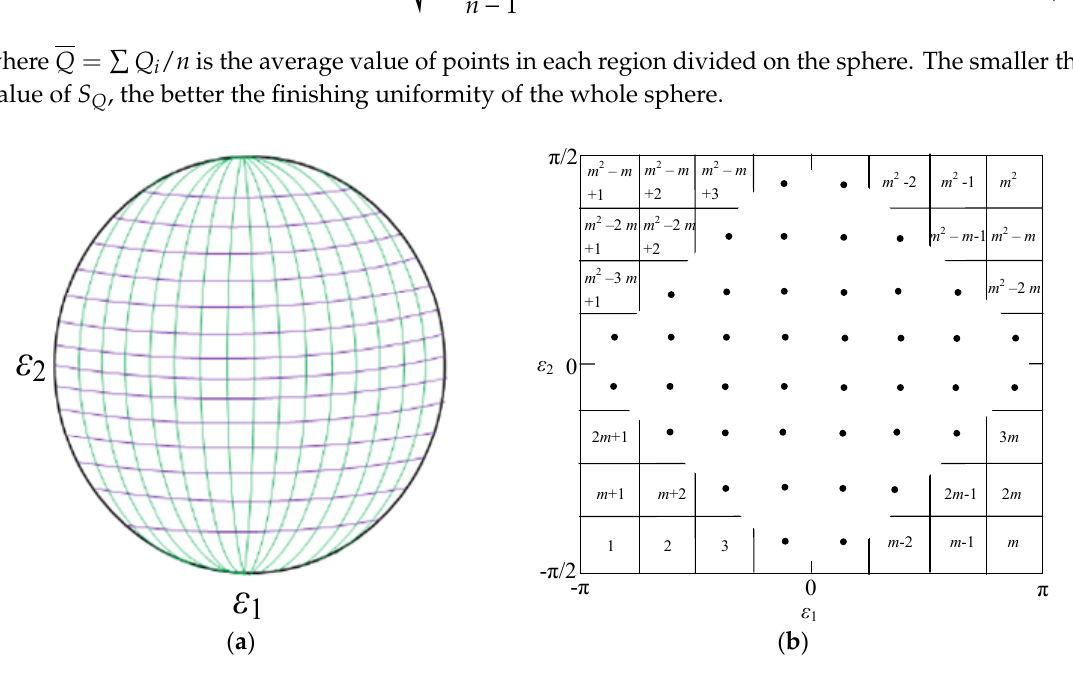
Figure 9. ( a ) the longitude-latitude meshing on a sphere ( b ) the m × m meshing of the spherical